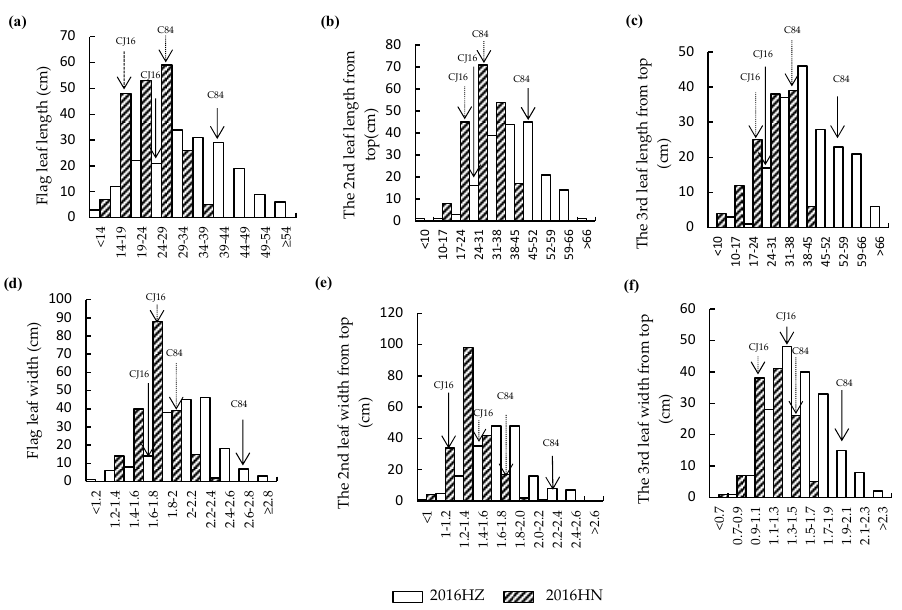
Figure 2. Frequency distributions of leaf traits in CJ16/C84 RILs. ( a ) Flag leaf length; ( b ) the second leaf length from top; ( c ) the third leaf length from top; ( d ) flag leaf width; ( e ) the second leaf width from top; ( f ) the third leaf width from top. HZ: Hangzhou; HN: Hainan.